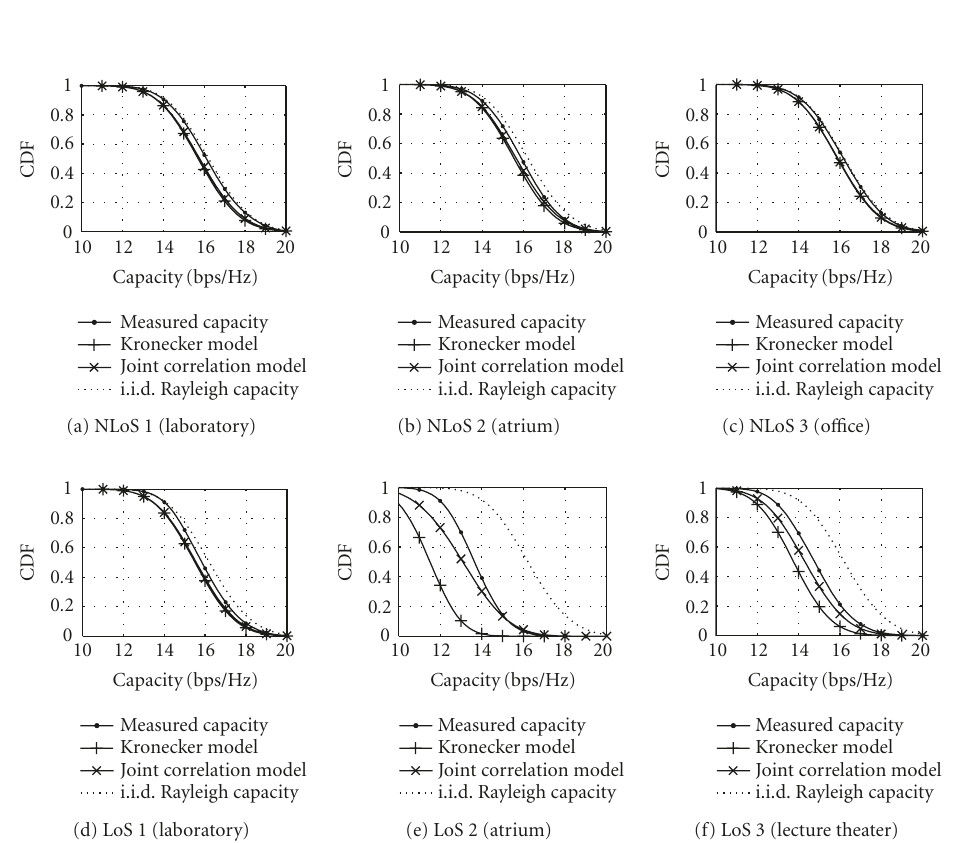
Figure 10: Comparison of measured, Kronecker model, joint correlation model, and i.i.d. Rayleigh capacity